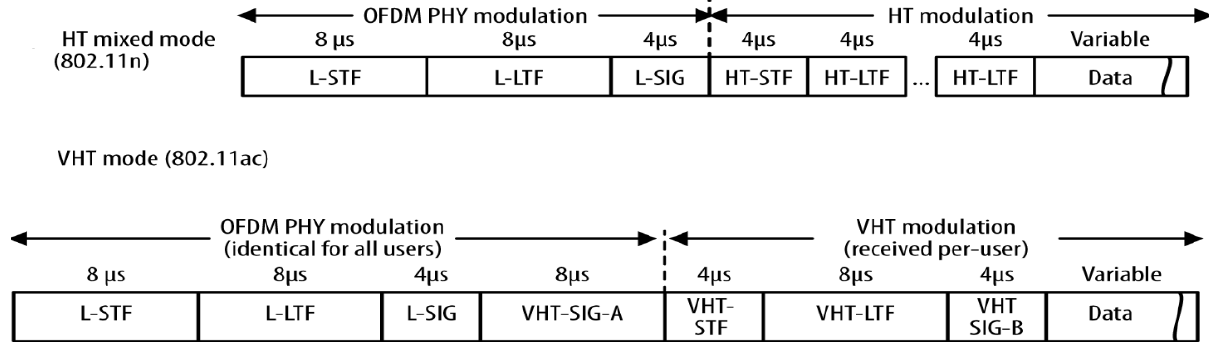
Figure 1. HT-mixed and VHT PPDU format